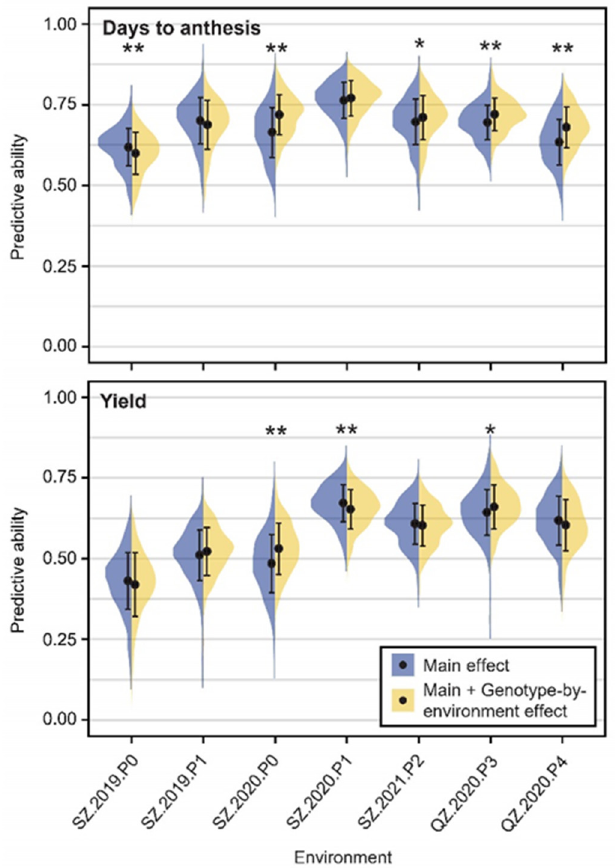
Figure 7. Genome-wide prediction results. Predictive ability in each environment using a model with only marker main effects or integrating main and genotype-by-environment interaction effects shown for days to anthesis and yield per hectare. The significance test between the two models was performed by t test. *, significant at 0.05 level; **, significant at 0.01 level. The point and bar represent mean and standard deviation value, respectively.